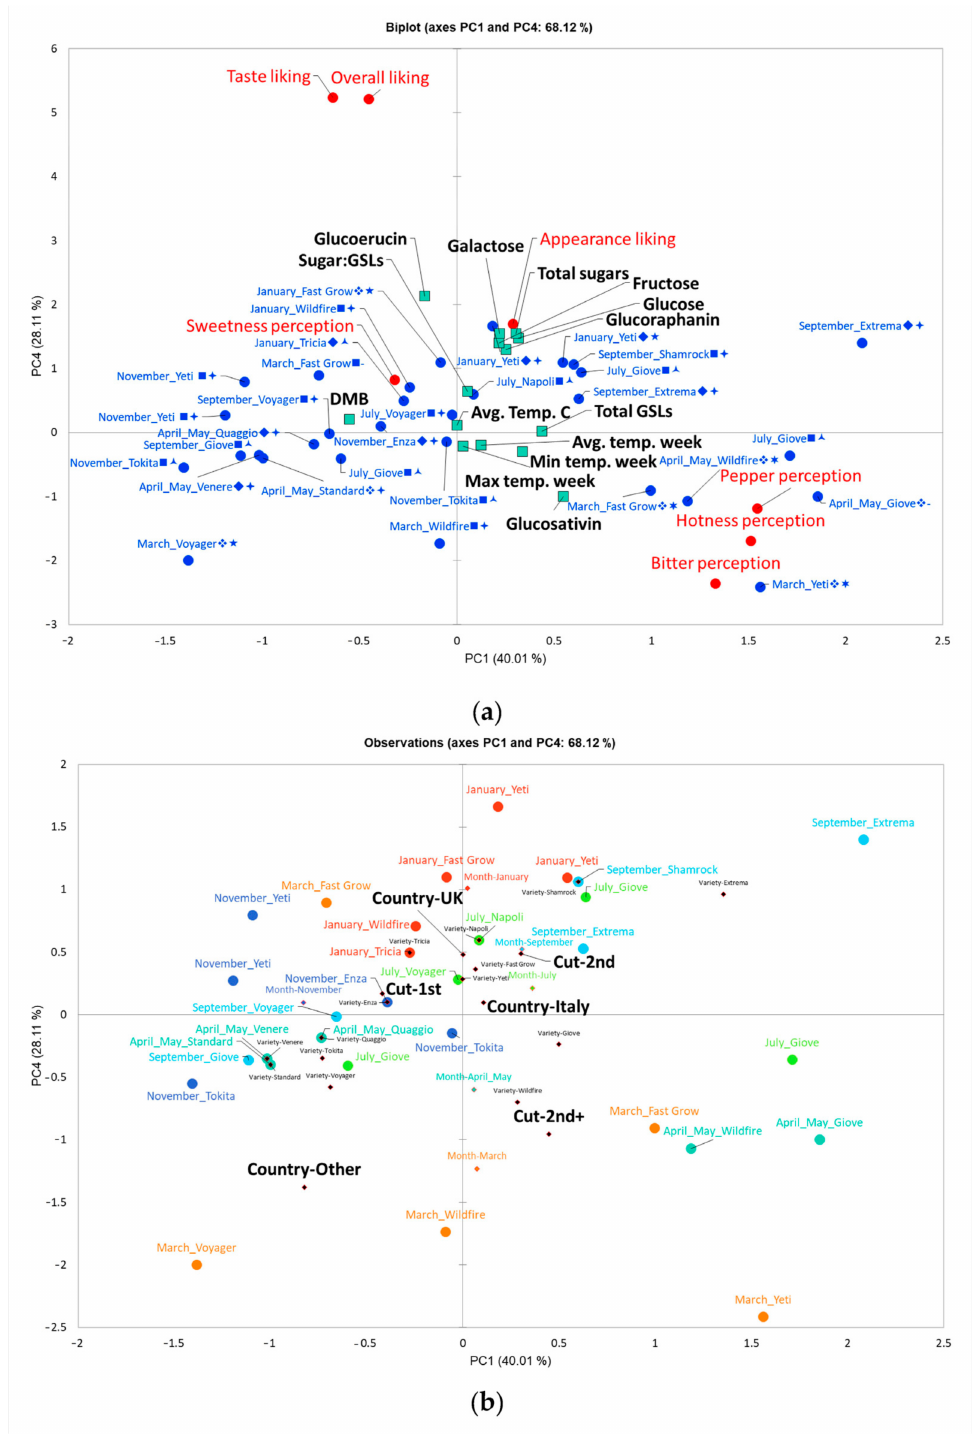
Table 1. Cultivation and origin details of rocket samples used for sensory and consumer analyses. Figure 3. Principal component analysis of consumer liking and perception data of rocket cultivars over the course of one growing season. Biplots display principal components (PCs) 1 and 4, which represent 68.1% of variation within the data; ( a ) factor loadings plot and ( b ) factor scores plot. In ( a ) red circles represent consumer liking and perception attributes, blue circles average monthly samples, and teal squares supplementary phytochemical, and cultivation temperature. Variable label symbols (refer to Table 1): (cid:4) = 1st cut; (cid:95) = second cut; = > 91 day crop cycle. In ( b ), see inset for monthly colour coding of samples. Black and red diamonds indicate supplementary variable